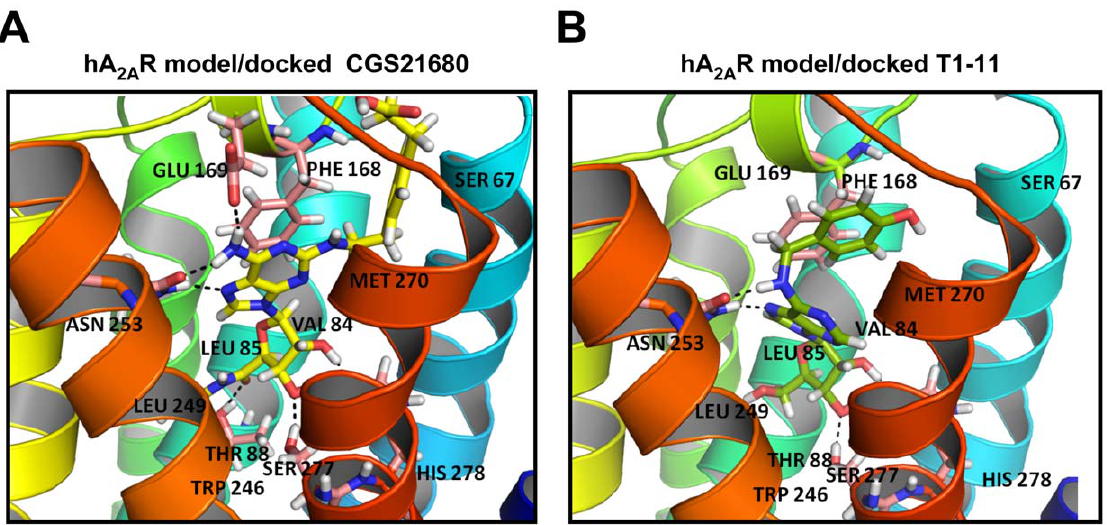
Figure 4. Interactions of the agonists with the ligand binding sites of the A 2A R. (A) The binding pose of CGS21680 (a selective agonist) on the human A 2A R, as predicted by combined homology modeling and docking analysis. The three-dimensional structure of the activated-state A 2A R was constructed based on the inactive-state structure of the A 2A R and the opsin structure. (B) Similar to (A), the binding pose of T1-11 on the